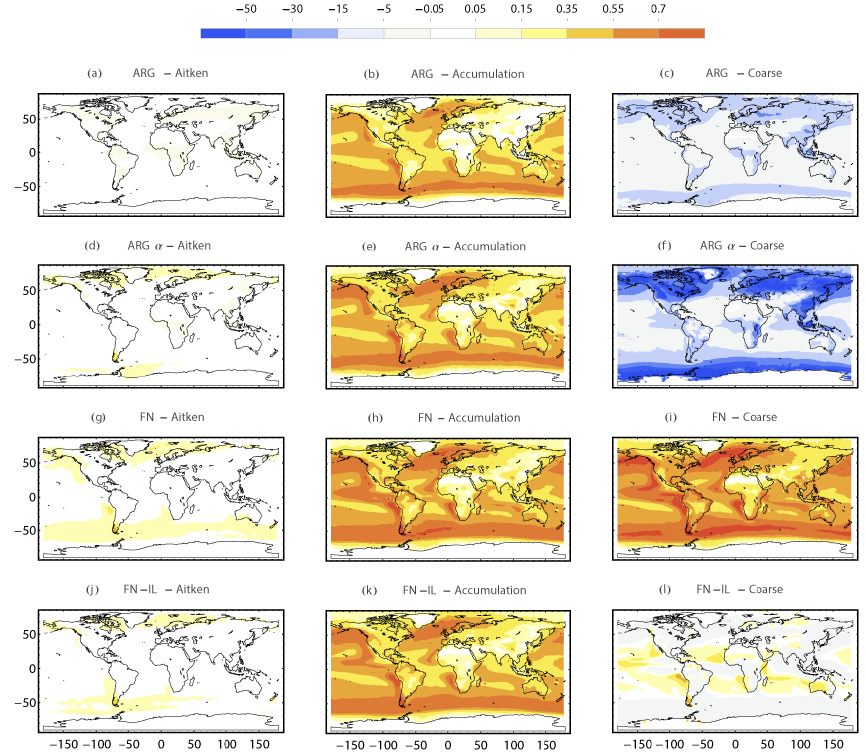
Fig. 2. Annual mean sensitivity to aerosol number concentration ∂N d /∂n a simulation, (d–f) ARG α -PD simulation, (g–i) FN-PD simulation, and (j–l) FN-IL-PD